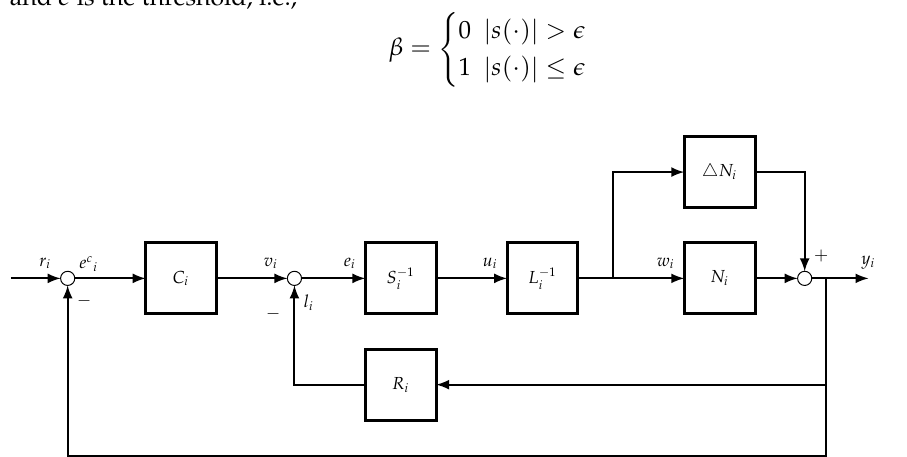
Figure 6. Nonlinear feedback tracking control of the MIMO